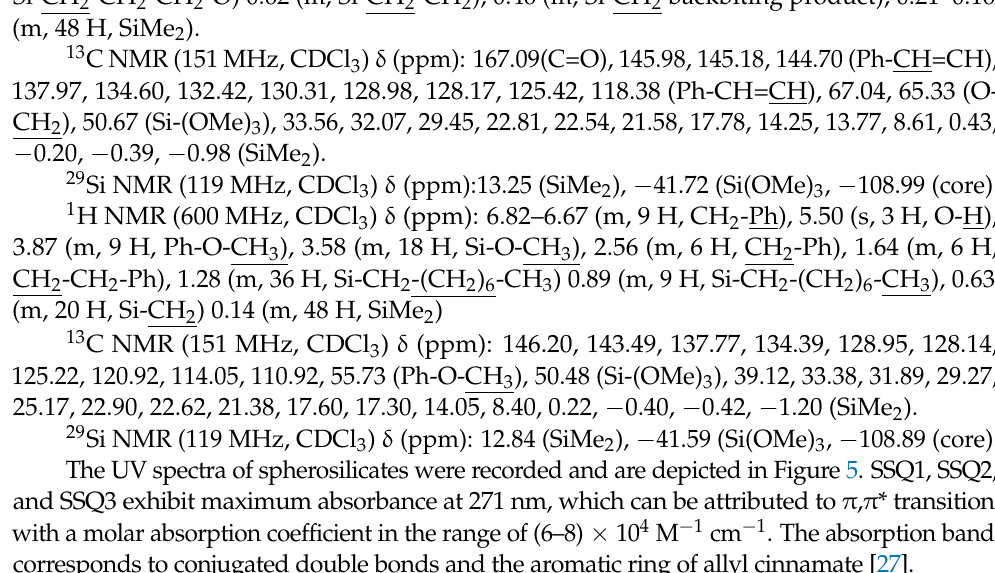
The UV spectra of spherosilicates were recorded and are depicted in Figure 5. SSQ1, SSQ2, and SSQ3 exhibit maximum absorbance at 271 nm, which can be attributed to π , π * transition with a molar absorption coefficient in the range of (6–8) × 10 4 M − 1 cm − 1 . The absorption band corresponds to conjugated double bonds and the aromatic ring of allyl cinnamate